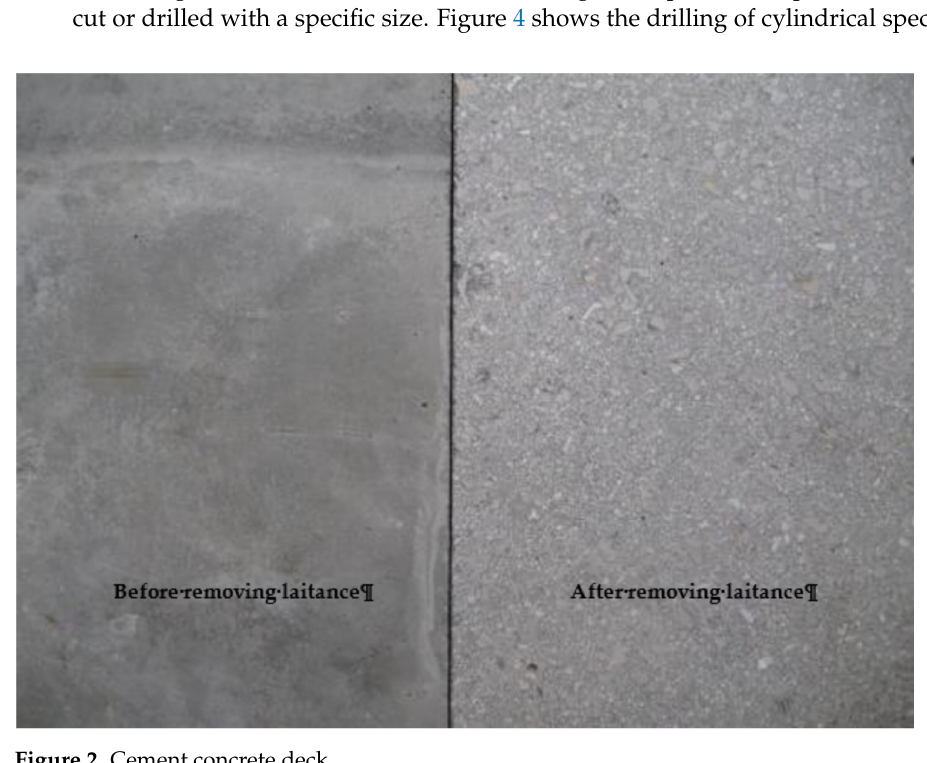
Figure 2. Cement concrete deck.